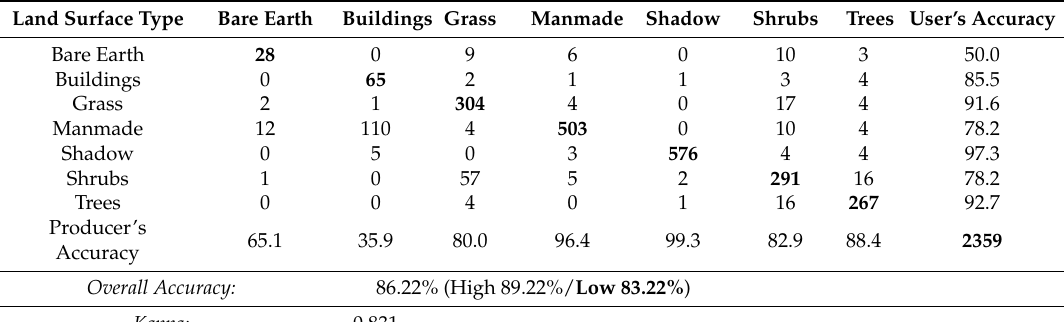
Table 6. Confusion Matrix for 2009/2010 image